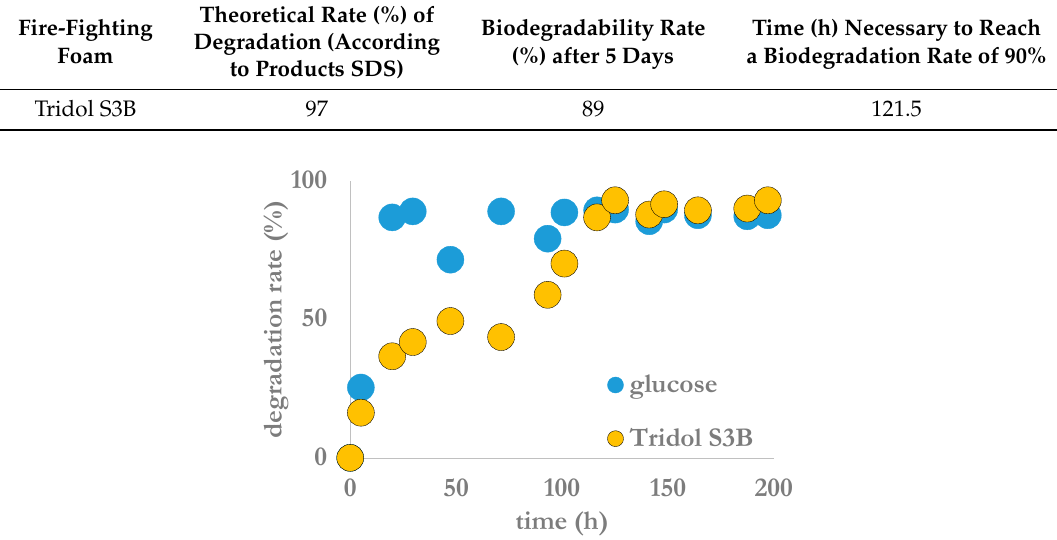
Table 3. Results of aerobic biodegradation tests on the three fire-fighting foams.